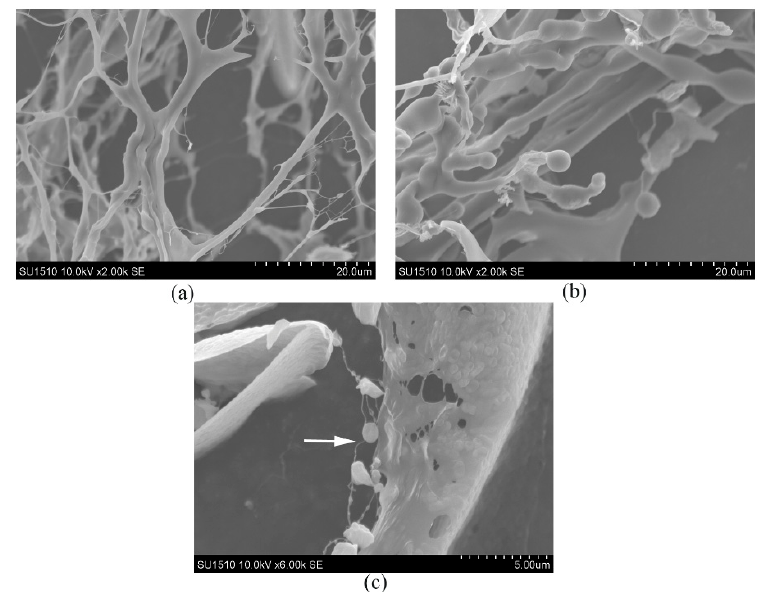
Figure 5. The microstructure and surface morphology micrographs of EPS-1a ( a ), EPS-2a ( b ), and EPS-3a ( c ) observed by SEM at an accelerating voltage of 10 kV.